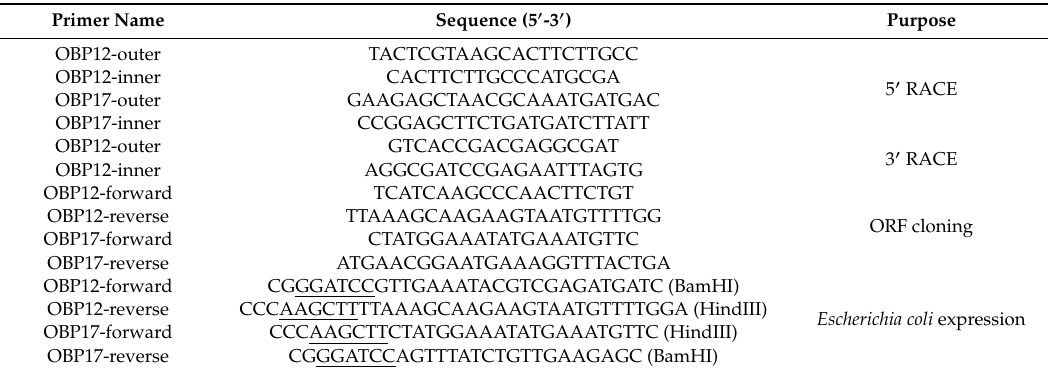
Table 1. Primers used in cloning and expression of Sitodiplosis mosellana odorant-binding proteins 12 and 17 (SmosOBP12 and